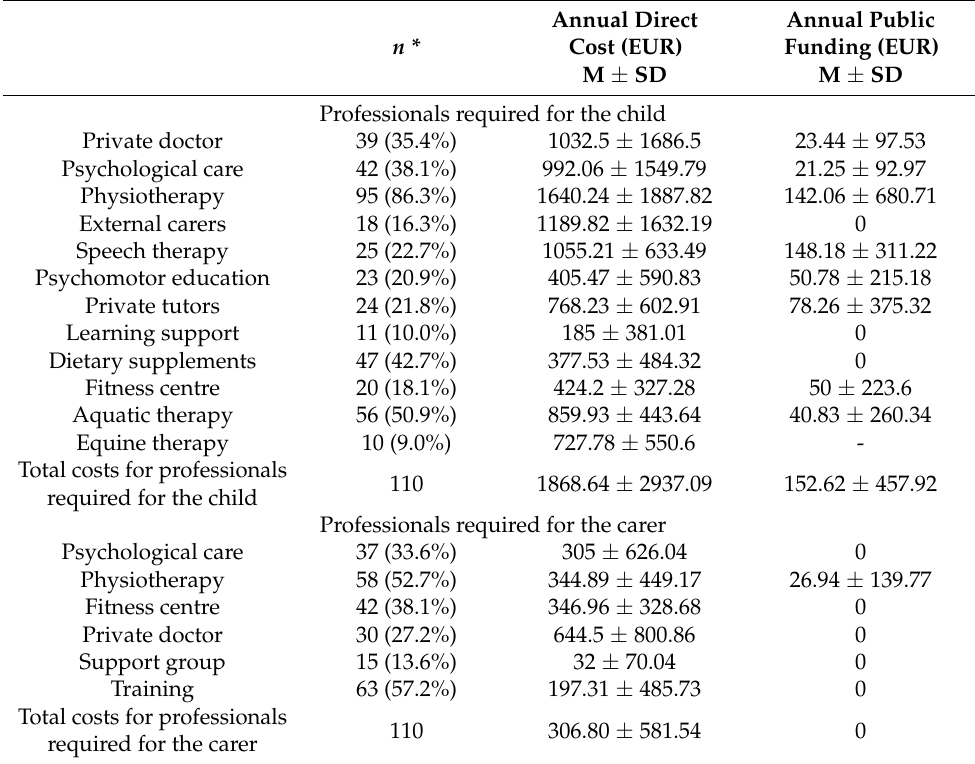
Table 2. Annual direct social welfare and health-related cost ( n =